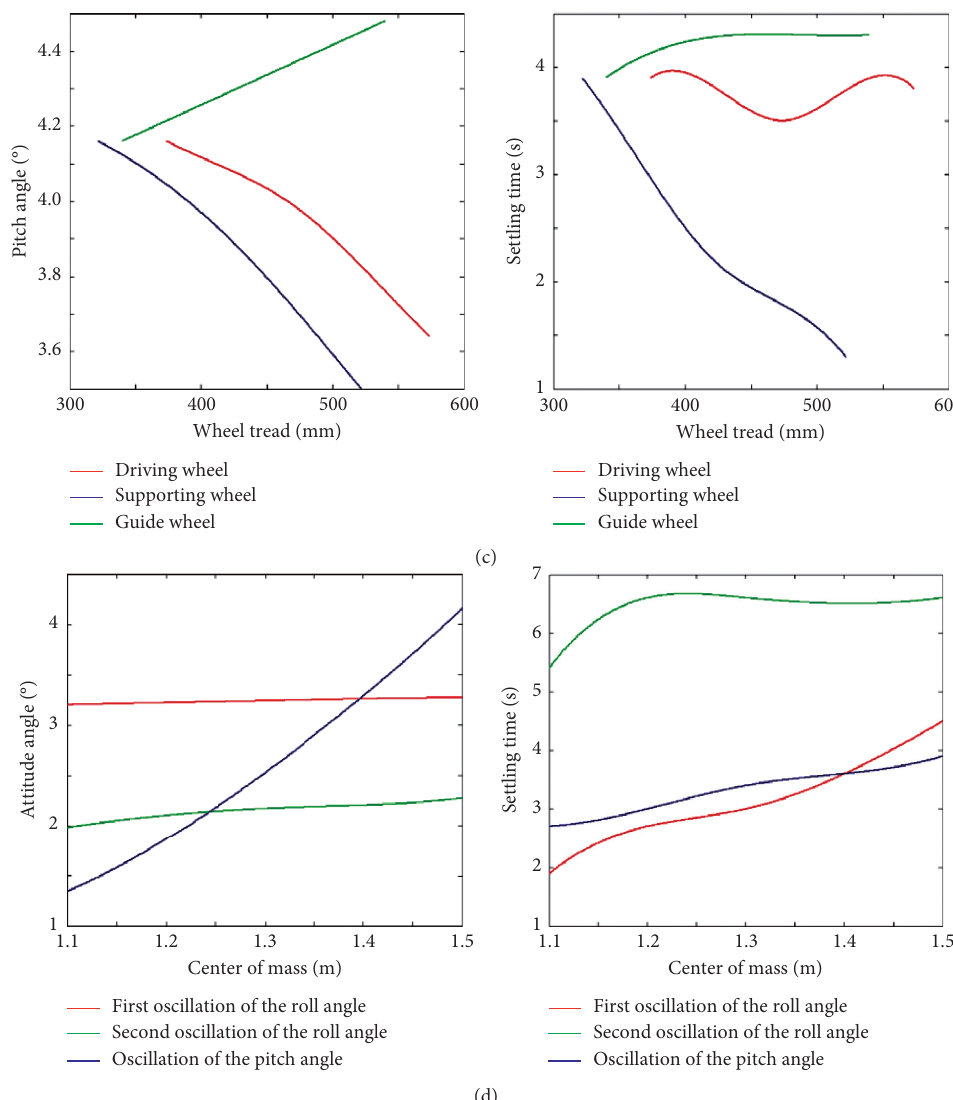
Figure 13: Variations of the amplitude and settling time of the attitude angle with different design parameters of the bogie on bend driving: (a) the first oscillation of the roll angle; (b) the second oscillation of the roll angle; (c) the oscillation of the pitch angle; (d) the influence of changes of the center of mass position on the attitude angle and settling time.